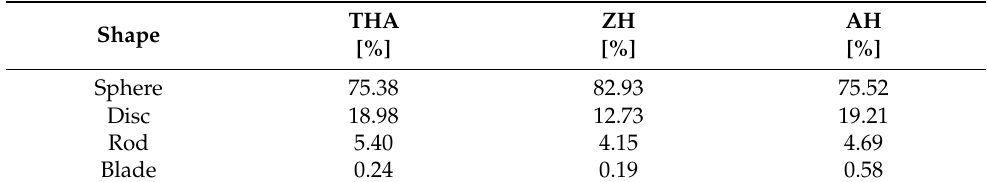
Table 7. The THA, ZH and AH shape characteristics based on the Zinng classification.